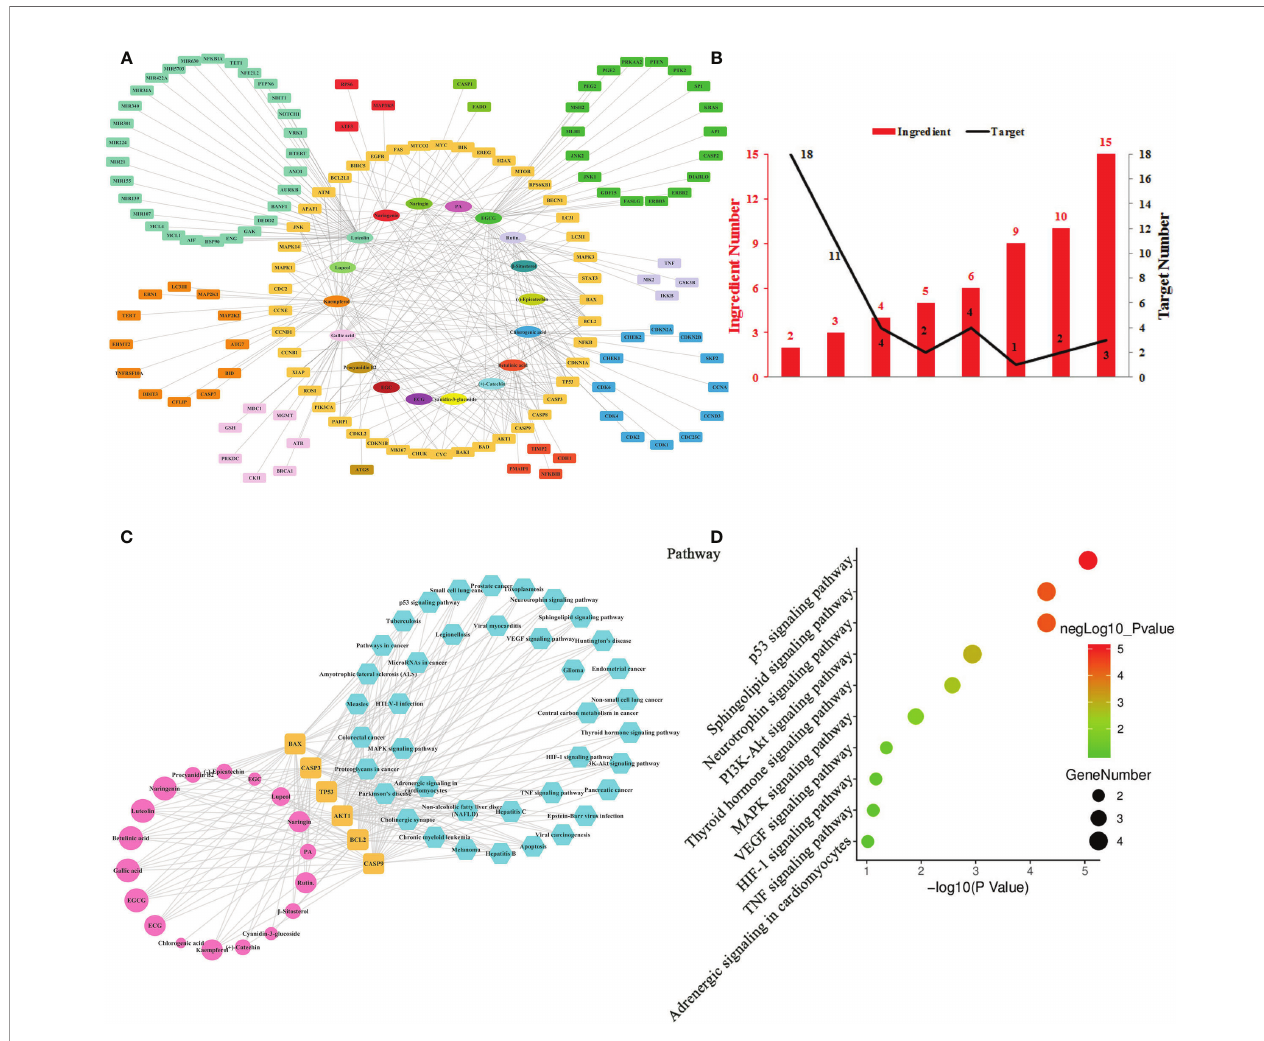
FIGURE 2 | Ingredient-Target Network of Litchi Inducing Cancer Cell Apoptosis and Autophagy. (A) The ingredient-target network of 18 ingredients (oval) associated with 138 targets (rectangle). (B) The histogram of “ ingredient and corresponding target number ” . (C) The ingredient-top target-signal pathway network. The round rectangle nodes (orange) represent 6 top targets, ellipse nodes (pink) represent 18 ingredients acting on top targets, the size of the nodes is illustrated from small to big in ascending order of degree values, the hexagon nodes (blue) represent signal pathways enriched based on top targets. (D) The top 10 pathways based on KEGG enrichment